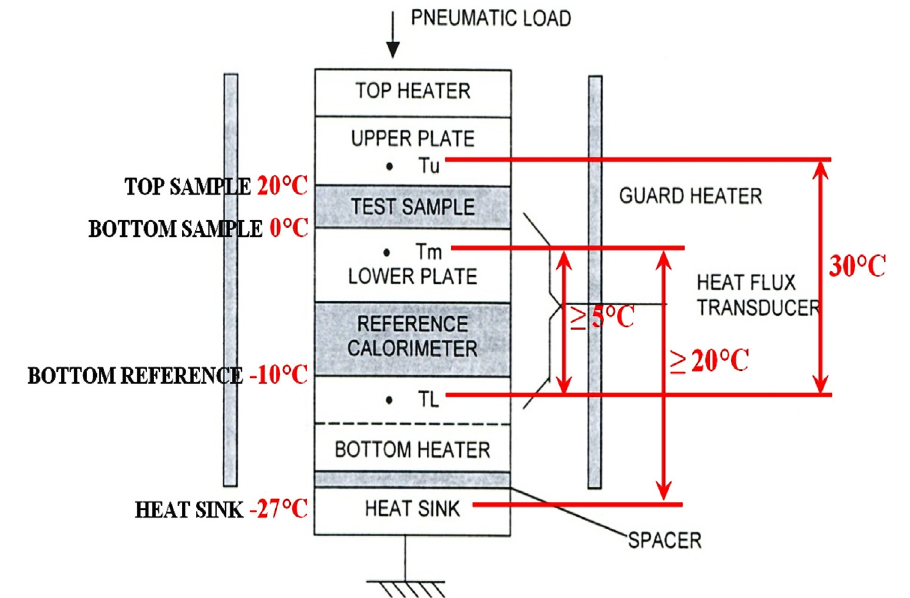
Fig. 2. (Color online) Test section schematic – temperature setting for 10 ◦ C